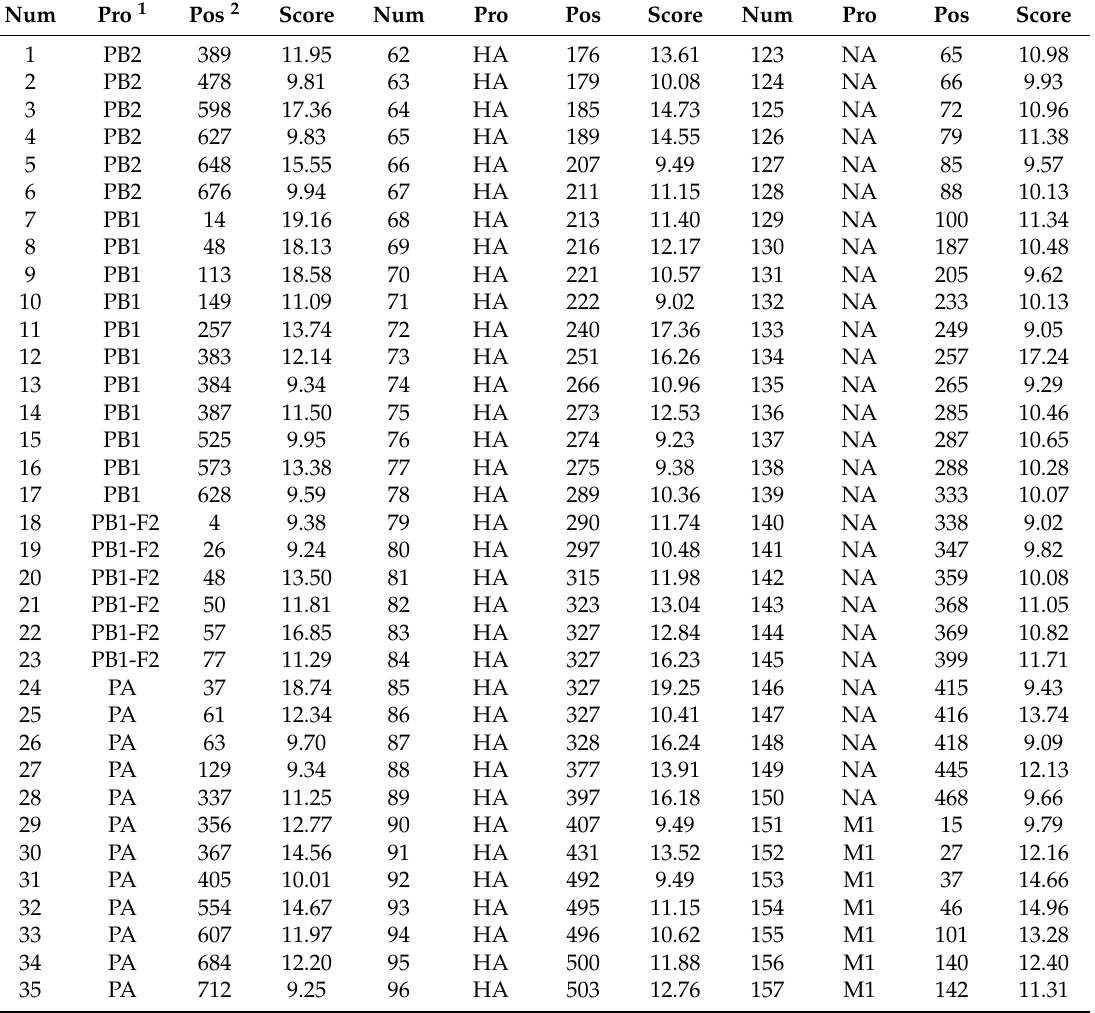
Table 1. Scores for the 183 signature amino acids of avian influenza viruses